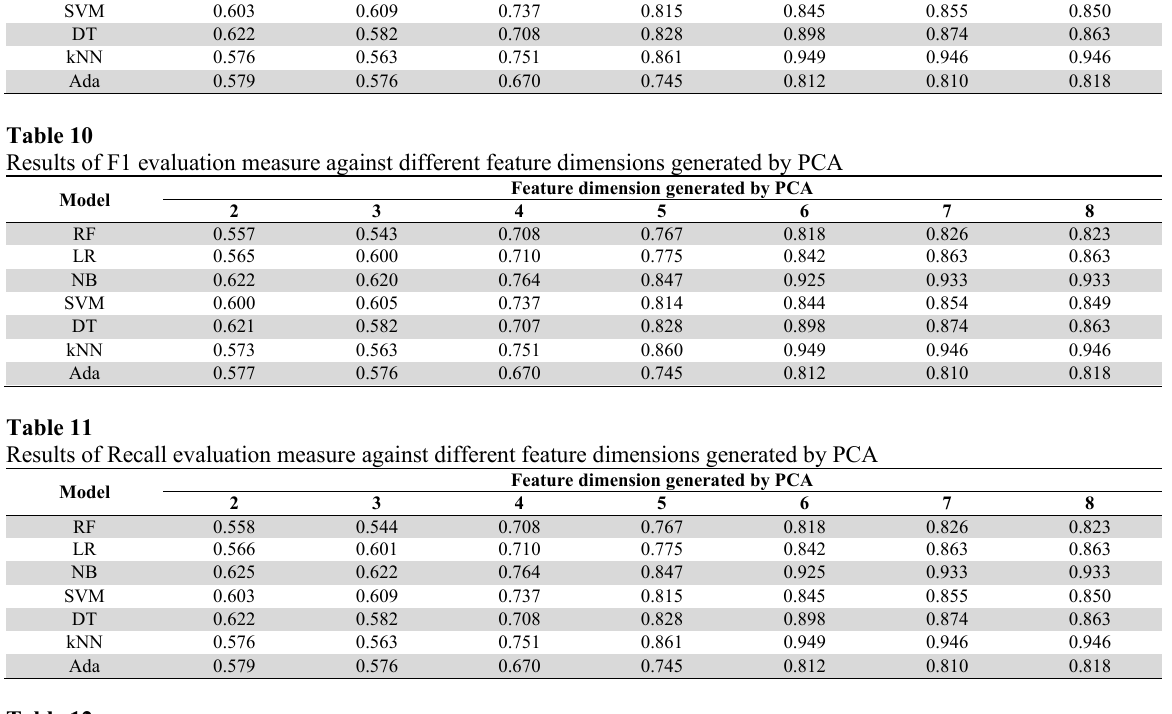
Results of Precision evaluation measure against different feature dimension generated by PCA Model